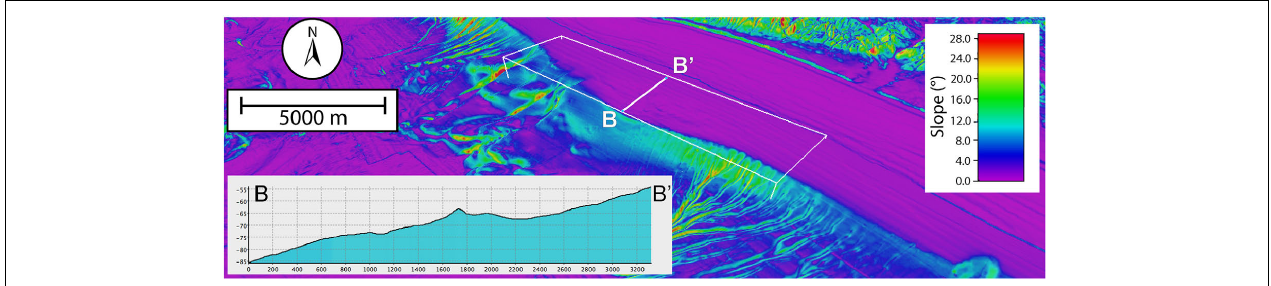
FIGURE 14 | Oblique view of continental shelf and slope bathymetry off the coast of San Onofre and San Clemente, showing location of survey in white 3D box. Colors denote slope angle. Inset shows slope along an arbitrary cross-section from B to B’ passing through large antiform coincident with widest part of the